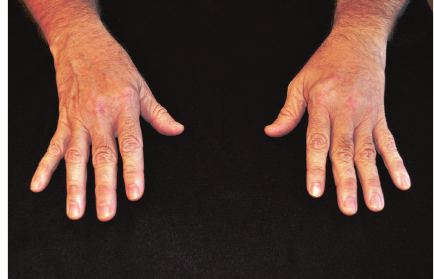
Figure 1: Clinical Photo of bilateral windblown hand.